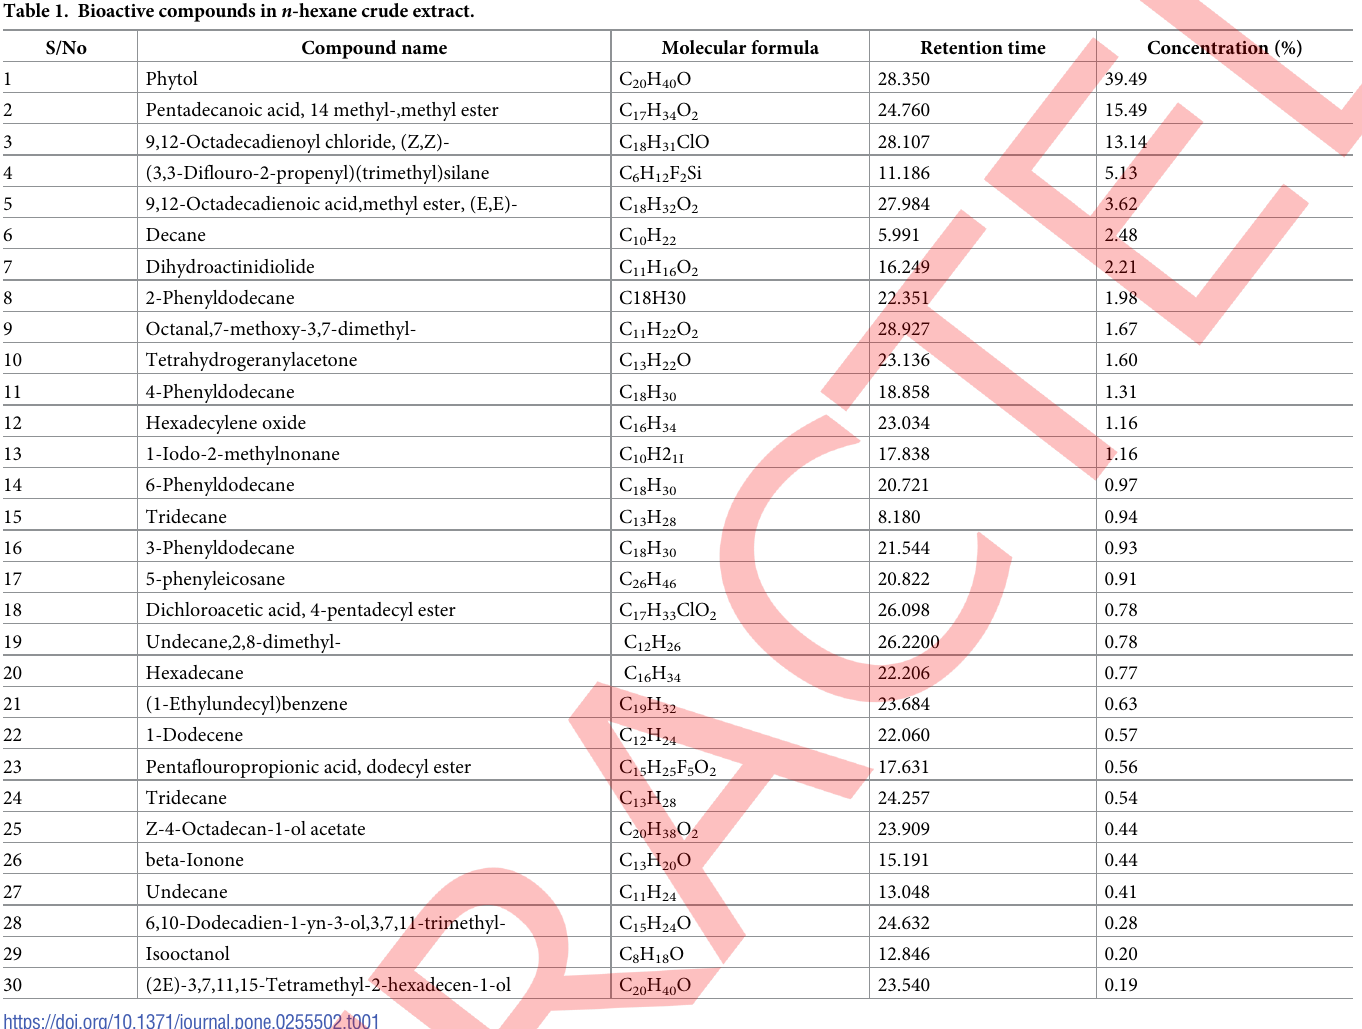
Table 1. Bioactive compounds in n -hexane crude